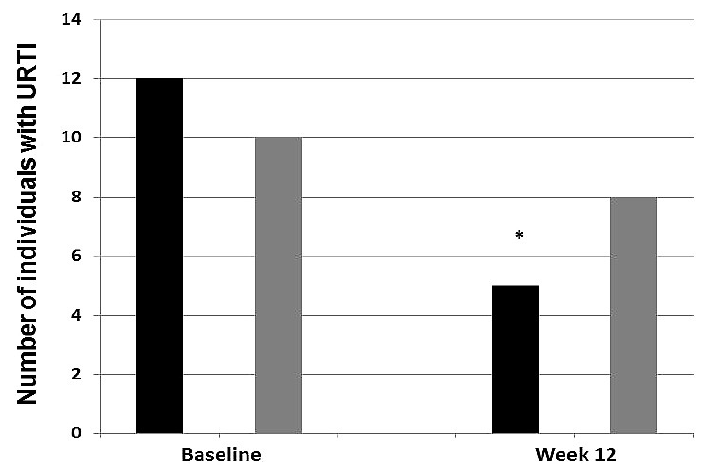
Figure 5. Incidence of upper respiratory tract infections (URTIs) in trained athletes before and after 12 weeks of treatment. The share of subjects on placebo (gray columns, 0.79) who experienced 1 or more URTI symptoms was 2.2 ‐ fold greater than those on probiotics (black columns, 0.35; * p = 0.016).